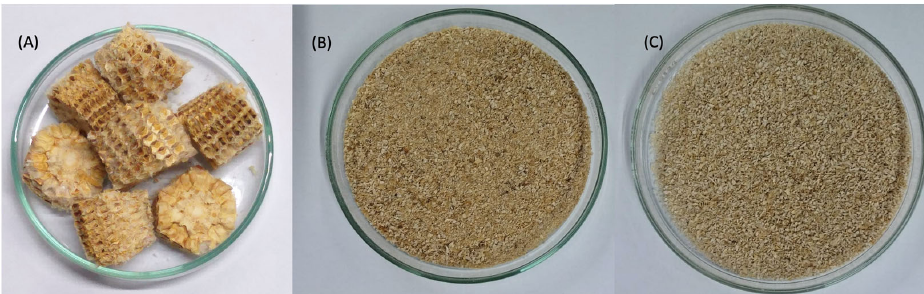
Figure 9. Residual Biomass from corn cob (CC) used as a support for Laccase from Aspergillus spp. (L asp ). ( A ) residual biomass in natura, ( B ) washed and sieved support, ( C ) defatted support. Adapted from